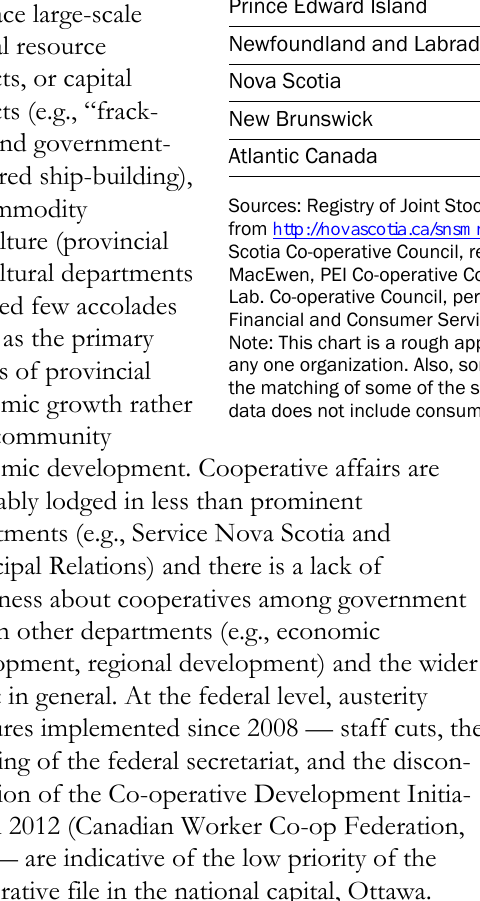
Table 1. Registered Agricultural Cooperatives by Subsector in Atlantic Canada